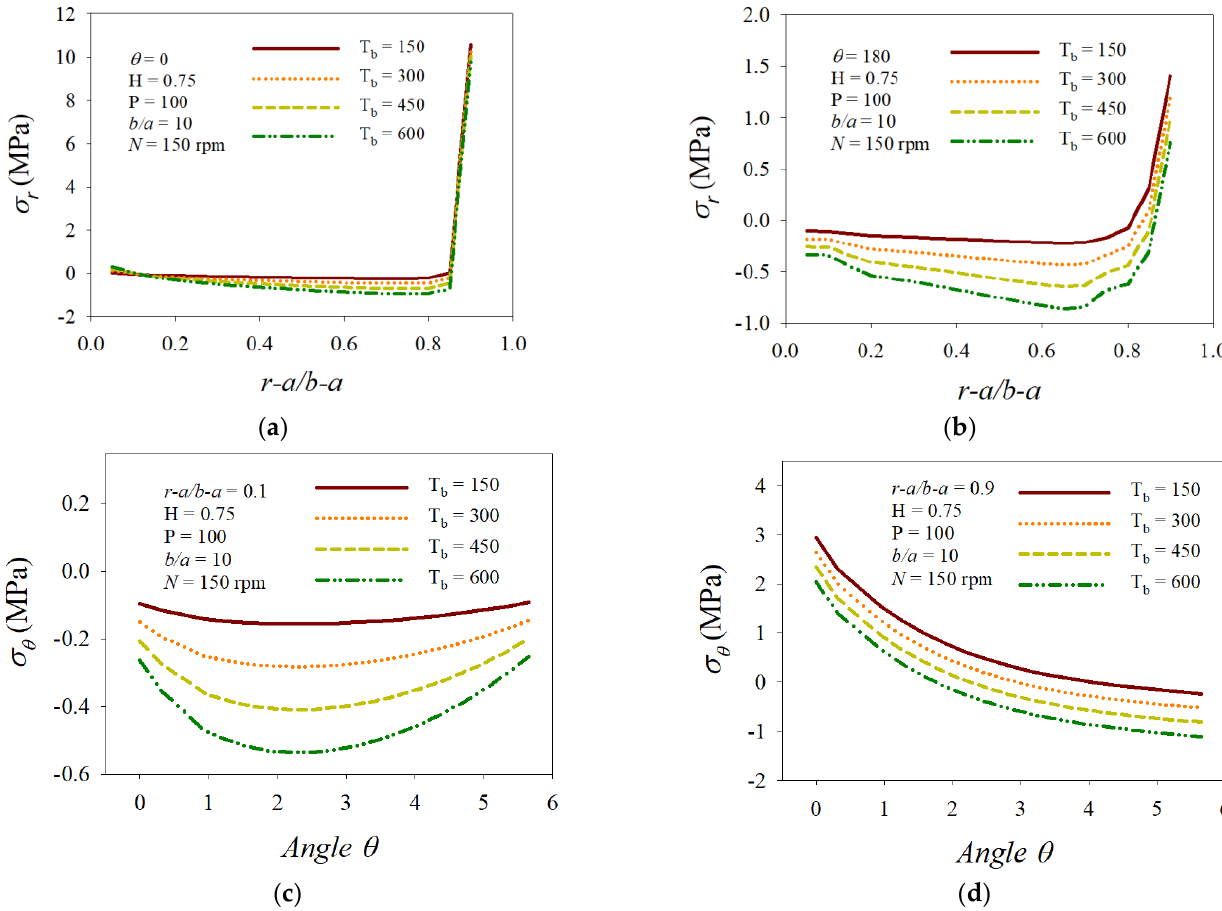
Figure 5. Effects of outer boundary temperature on the components of stress: ( a ) Radial at θ = 0 , ( b ) radial at θ = 180 , ( c ) circumferential at (r − a)/(b − a) = 0.1, ( d ) circumferential at (r − a)/(b − a) = 0.9.